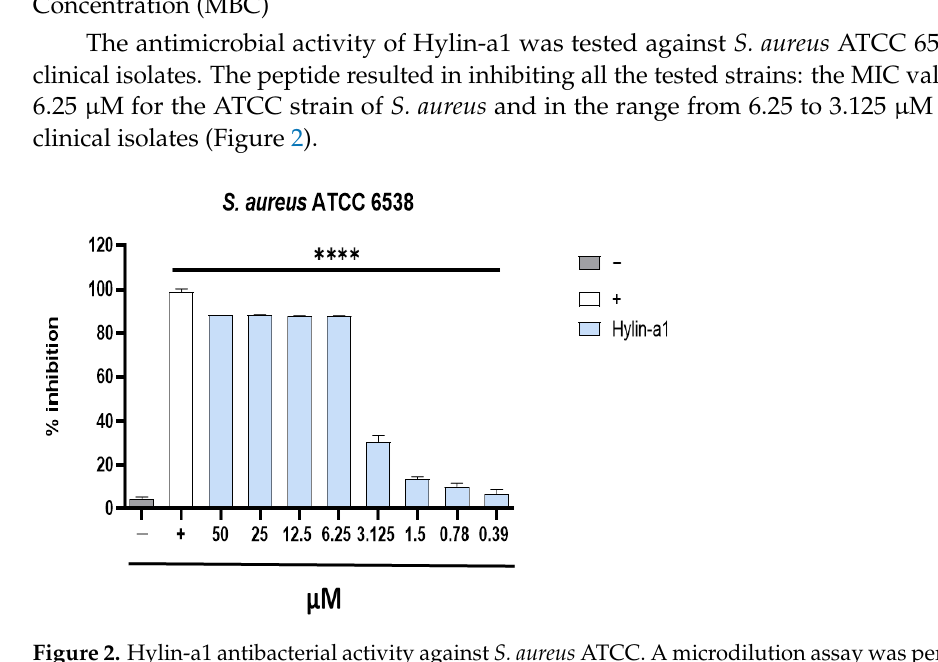
Figure 2. Hylin-a1 antibacterial activity against S. aureus ATCC. A microdilution assay was per- formed in order to evaluate the activity against S. aureus ATCC. As a positive control (+) vancomycin (6.9 μ M) was used, while bacterial medium represented the negative control (−). **** p <